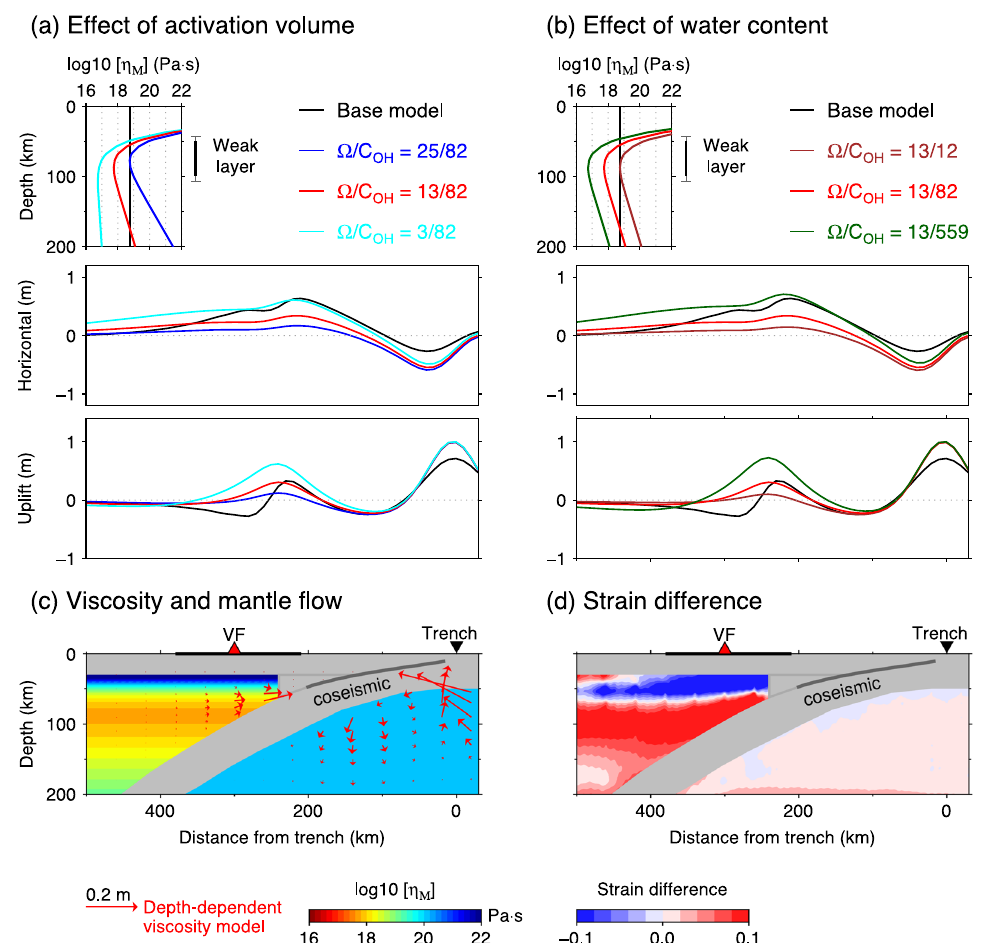
Fig. 6 The effect of depth-dependent viscosity on the 3-year postseismic deformation. a The surface displacement by the model with depth-dependent viscosity in mantle wedge where activation volume (cid:31) vary 25, 13, and 3 cm 3 /mol with a fixed water content C OH of ~ 82 ppm H/Si. The corresponding 1-D viscosity profiles are shown in top panel. b The surface displacement by the model where C OH vary as ~ 12, ~ 82, and ~ 559 ppm H/Si with fixed (cid:31) of ~ 13 cm 3 /mol. The corresponding 1-D viscosity profiles are displayed in top panel. See model details in Additional file 1: Table S2. c The trench-normal profile shows the viscosity distribution and mantle flow pattern for the model with (cid:31) mol and C OH 82 ppm H/Si are shown. d The distribution of strain difference corresponds to the model shown in ( c ). Strain difference = the depth-dependent model – strain in the base model. All viscous strain (second invariant of the deviatoric strain tensor) is normalized by